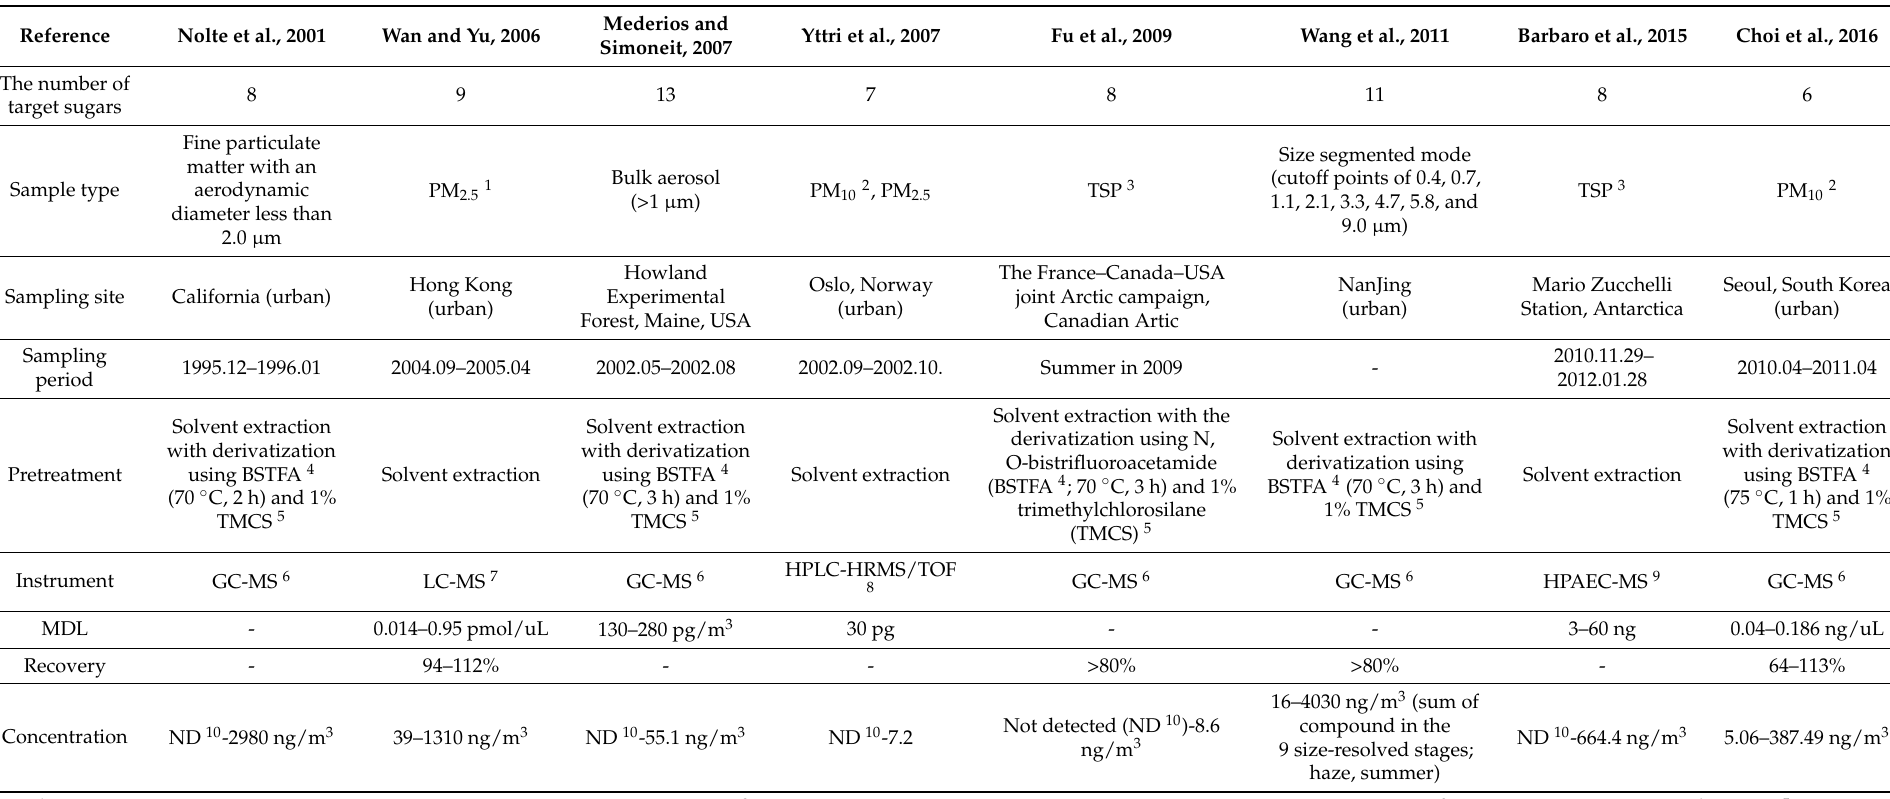
Table 1. The analytical method, method detection limit, recovery, and ambient concentration of saccharides in particulate matter samples collected in polar environments and urban areas in previous